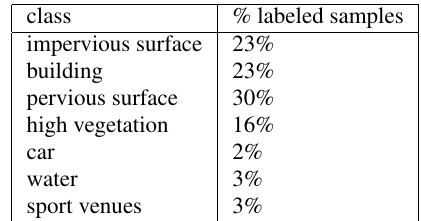
Table 1. Classes available on the Semcity Toulouse dataset